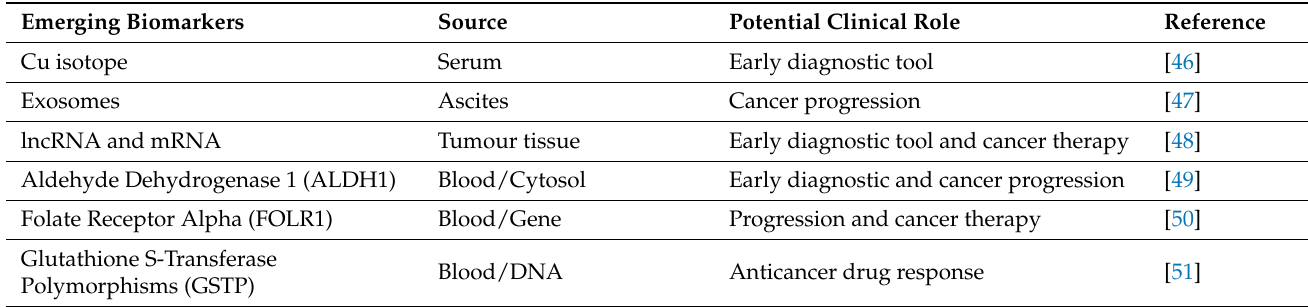
Table 2. Potential newly emerging biomarkers and their clinical utility in ovarian cancer